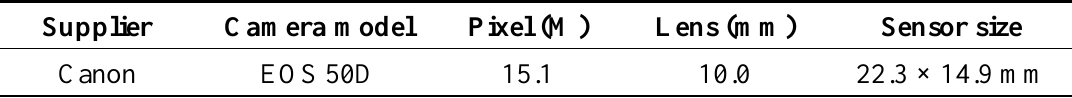
Table 3. Configurations of digital